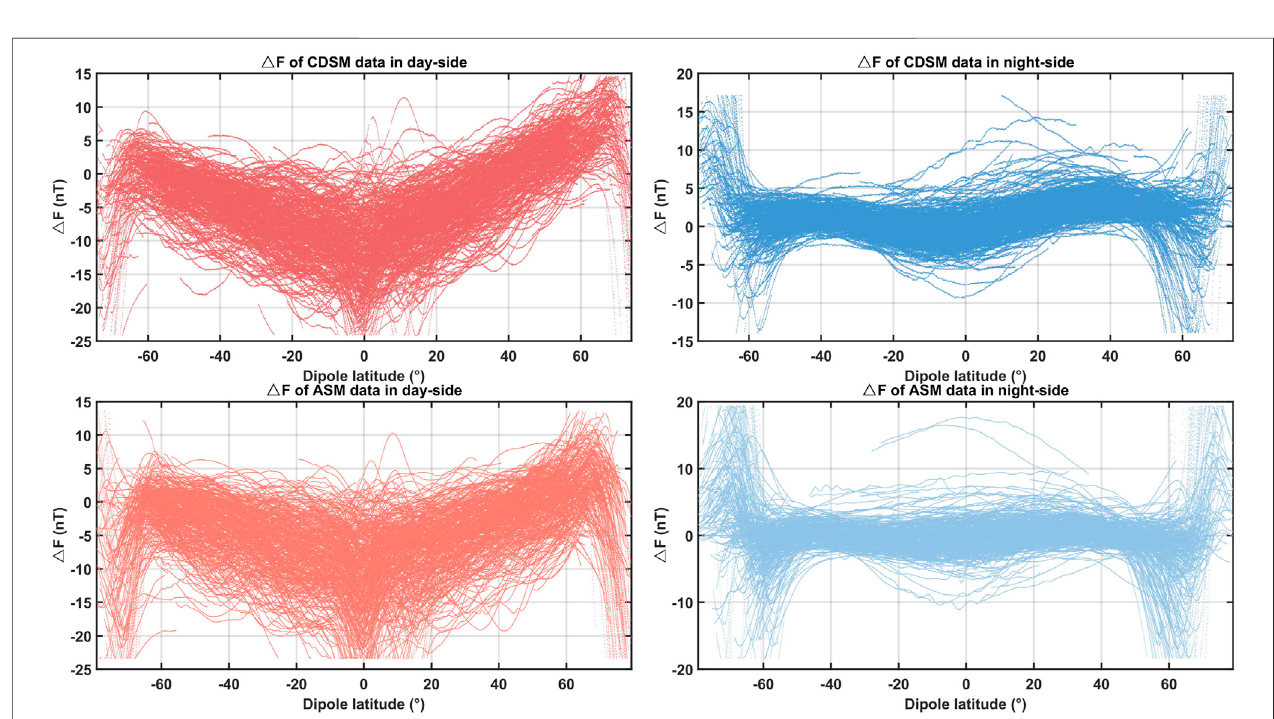
FIGURE 6 | Δ F distribution along the dipole latitude from 31 July 2019 to 30 September 2019 (red dots represent the Δ F of the day-side data, and blue dots represent the Δ F of the night-side data).